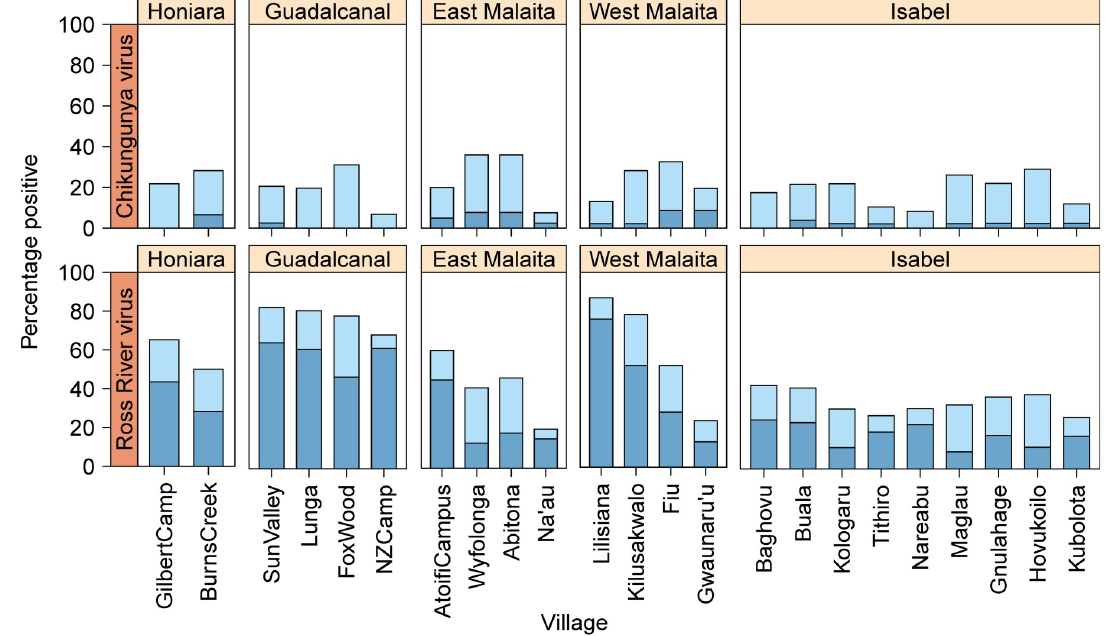
Fig 3. The seroprevalence of alphaviruses across villages in the Solomon Islands. The darker blue colour represents samples that were alphavirus-positive for chikungunya or Ross River virus alone. The lighter blue colour represents samples that were positive for both chikungunya and Ross River